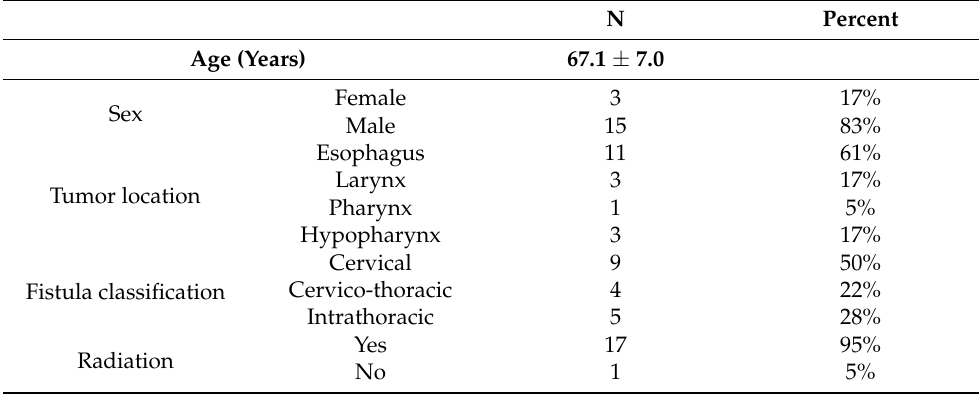
Table 1. Description of the patient cohort treated for